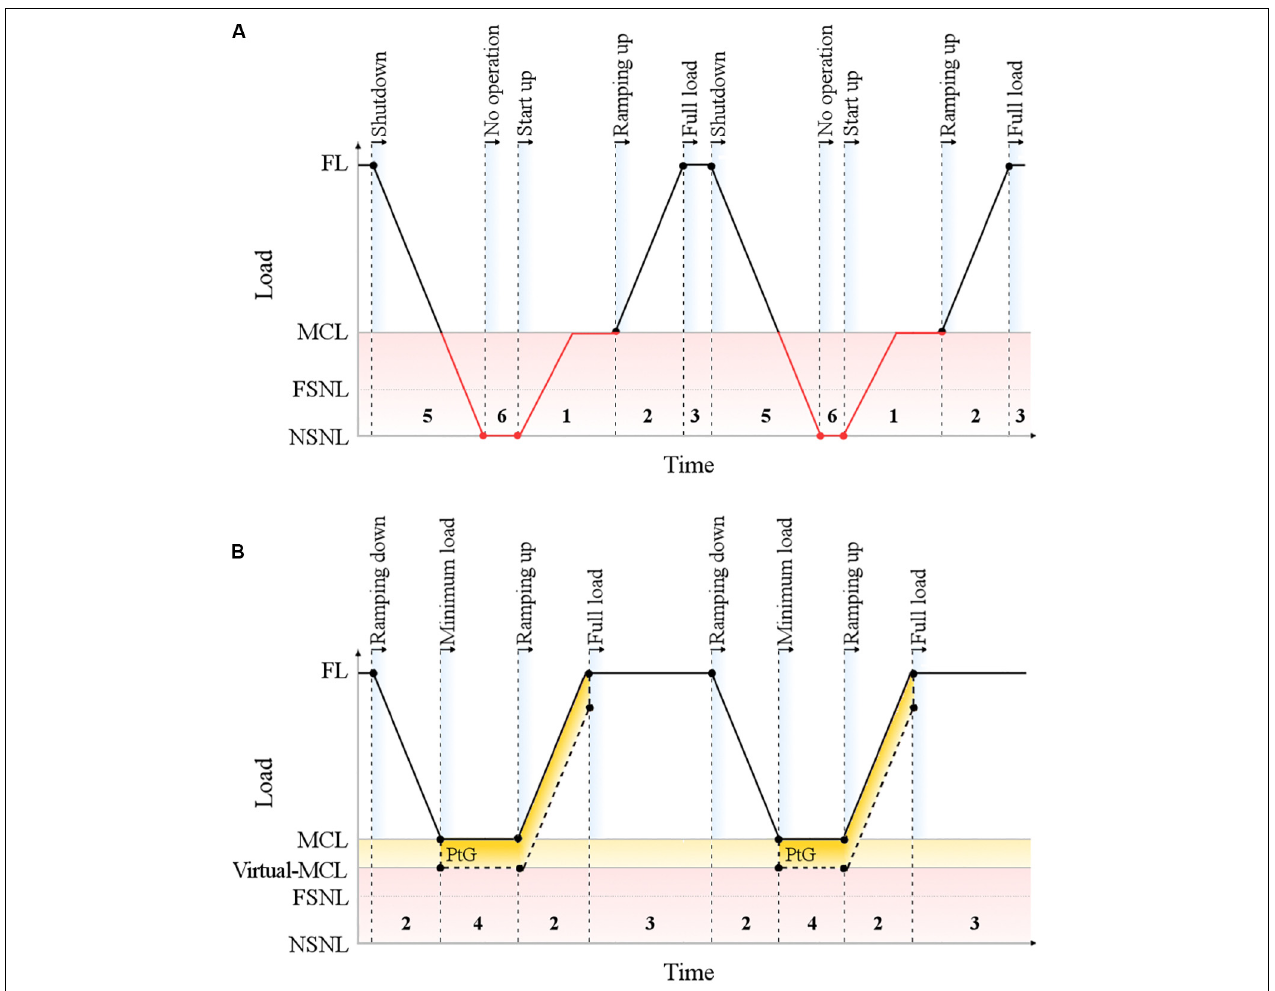
FIGURE 4 | Comparison between (A) conventional combined cycle power plant (CCPP) and (B) PtG-assisted CCPP while satisfying a peak of demand that takes place in the middle of a dispatch below the minimum complaint load.